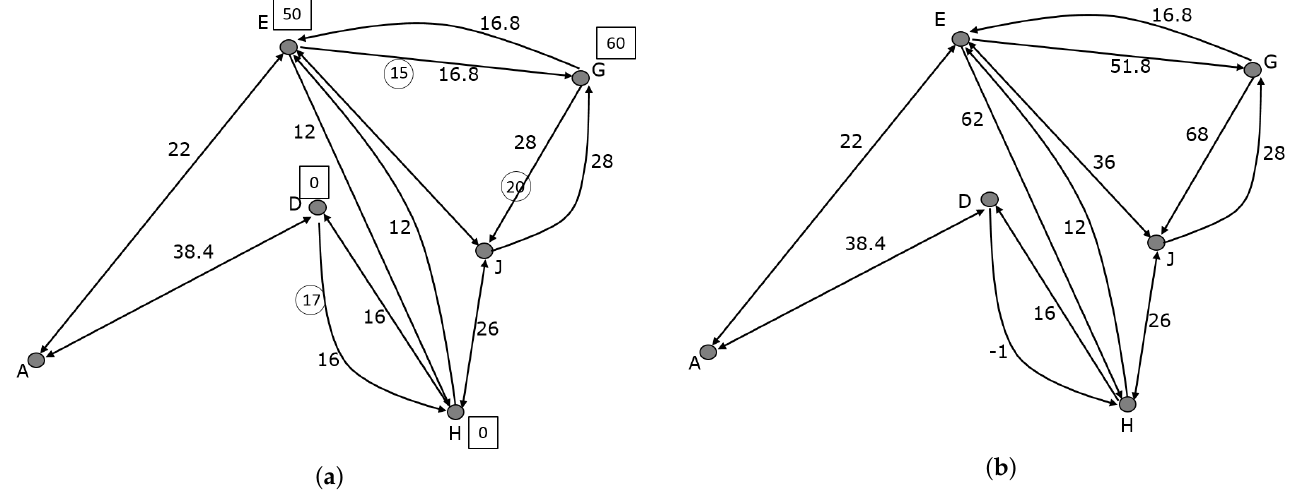
Figure 7. Graphical representation of the graph G (cid:48) reflecting: ( a ) the costs provided in the statement of the problem and ( b ) the cost of each arc already